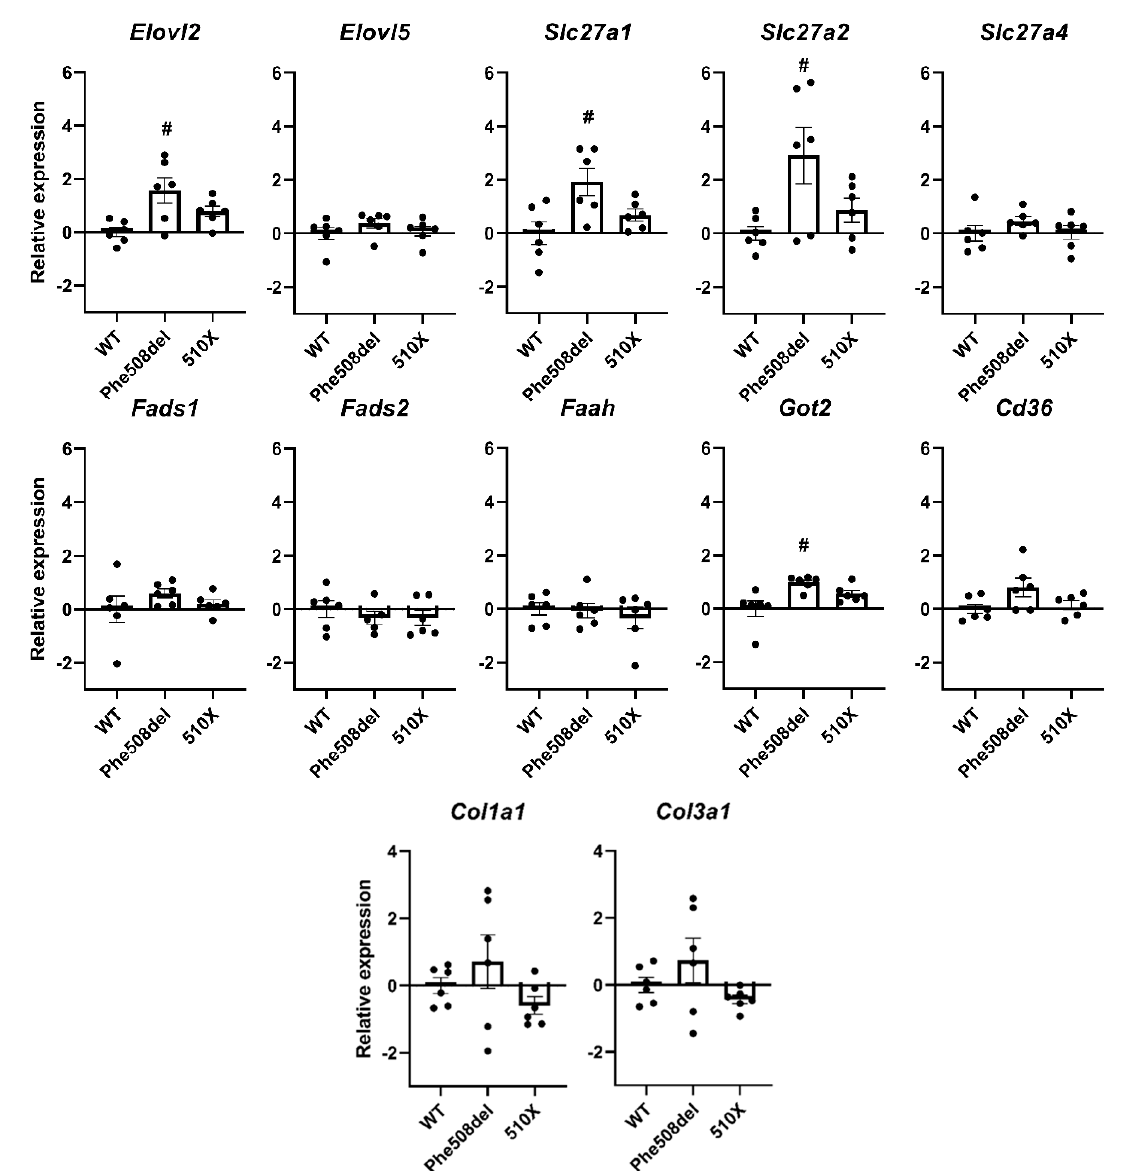
Figure 2. Expression of fatty acid synthesis and transport, and fibrotic mRNA in ileum of 1 month- ld CF rats. Expression of Elovl2 , Elovl5 , Fads1 , Fads2 , Slc27a1, Slc27a2, Slc27a4, Faah, Got2, CD36 , Col1a1 and Col3a1 in wild-type, Phe508del and 510X rat ileum was normalized to the average expression of the housekeeping genes β -actin and cyclophilin A. The relative expression in the Phe508del and 510X ileum was compared to the wild type. Data are expressed as the mean ± SEM and analyzed by a one-way ANOVA with Dunnett’s multiple comparisons test to determine significance. # indicates p < 0.05, n = 5–6.